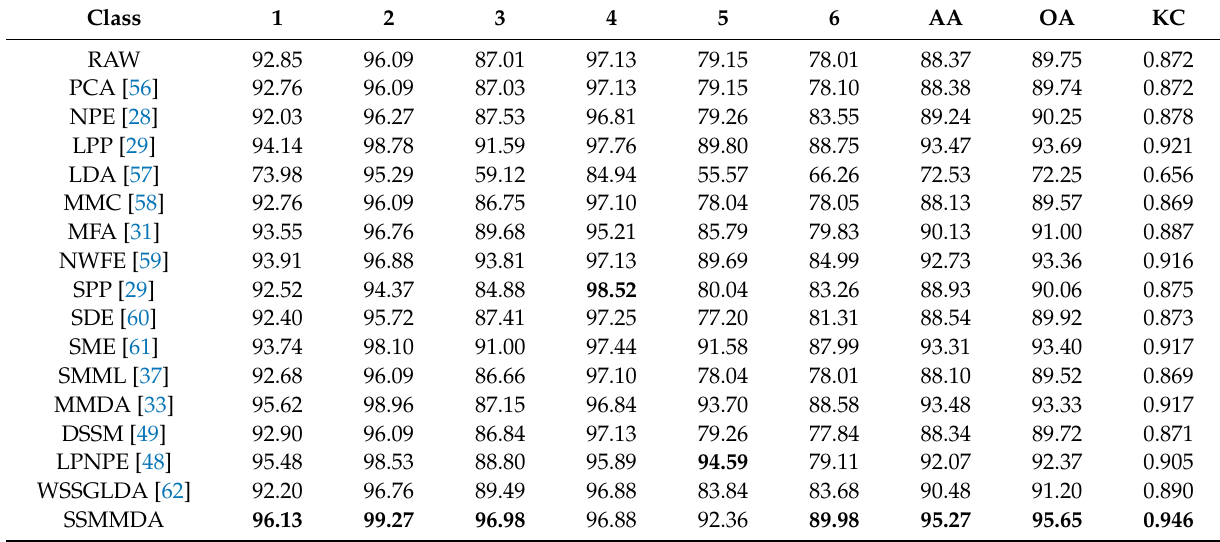
Table 6. Classification results (%) of each class (t = 1%) with NN classifier on the Washington DC Mall data